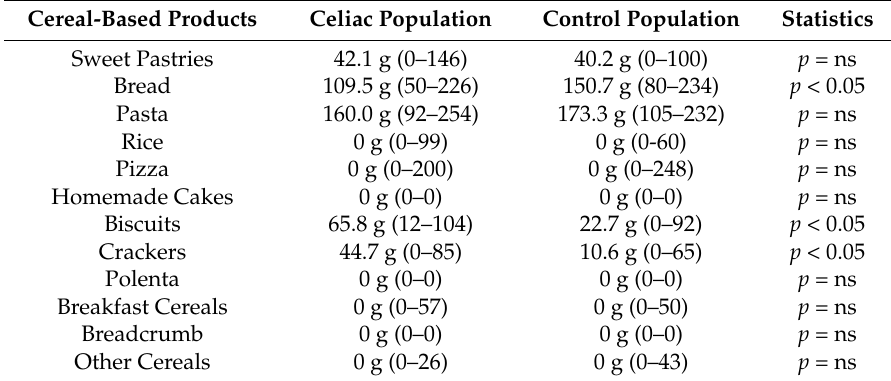
Table 2. Consumption of cereal-based products in celiac disease (CD) subjects compared to controls. Data are expressed as median three-day consumption and inter-quartile range. Mann–Whitney test was used to compare group data.